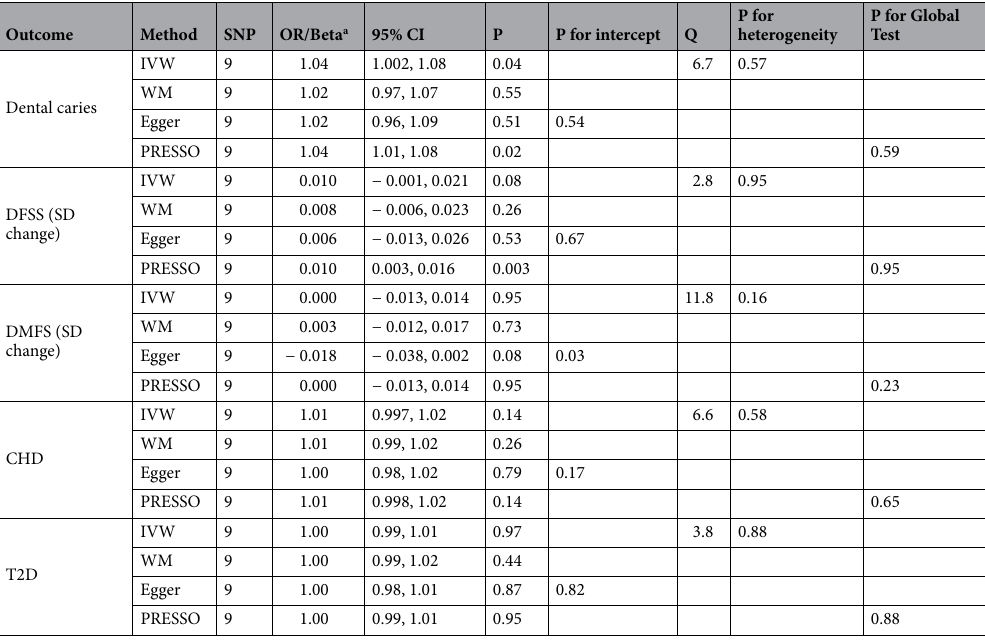
Table 1. Associations of genetically predicted blood sucrose (per log 10 transformed median-normalized SD increase) with dental caries [from the UK Biobank ( n case = 2110, n control = 359,084)], DFSS and DMFS [from the GLIDE consortium, n = ~ 26,792], CHD [from a meta-analysis in the CARDIoGRAMplusC4D consortium ( n case = ~ 76,014, n control = ~ 264,785)] and T2D [from a meta-analysis in the DIAGRAM Consortium ( n case = 74,124, n control = 824,006)]. CHD coronary heart disease, CI confidence interval, DFSS decayed and filled tooth surfaces divided by tooth surfaces, DMFS decayed, missing and filled tooth surfaces, Egger MR-Egger, IVW inverse variance weighting, OR odds ratio, PRESSO MR-PRESSO, SD standard deviation, SNP single nucleotide polymorphism, T2D type 2 diabetes, WM weighted median. a Beta for DFSS and DFMS and OR for other